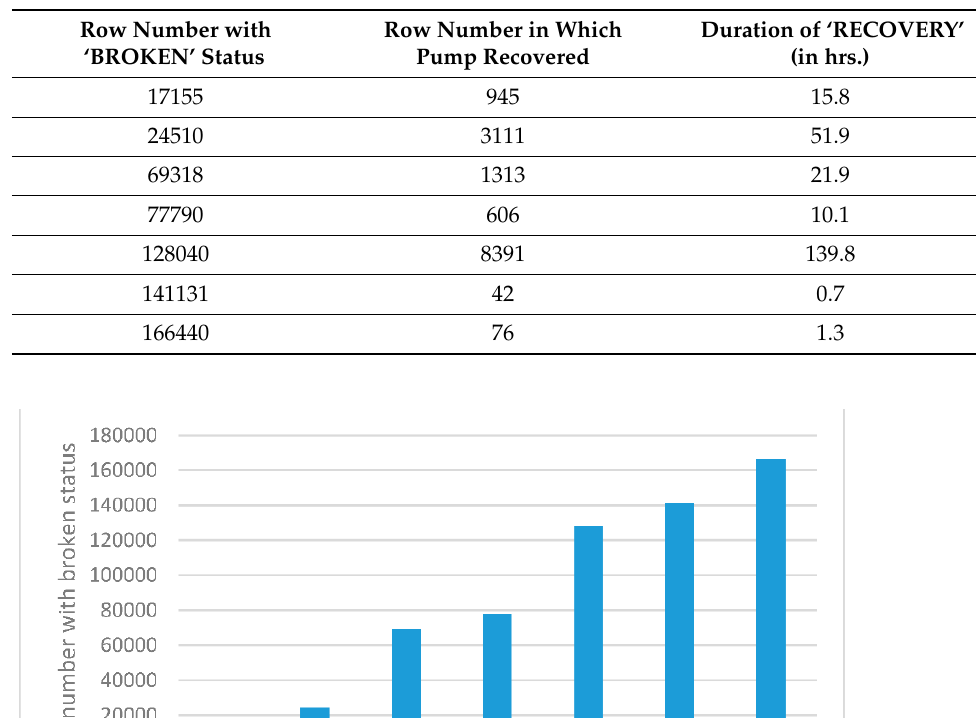
Table 1. Pump recovery status.